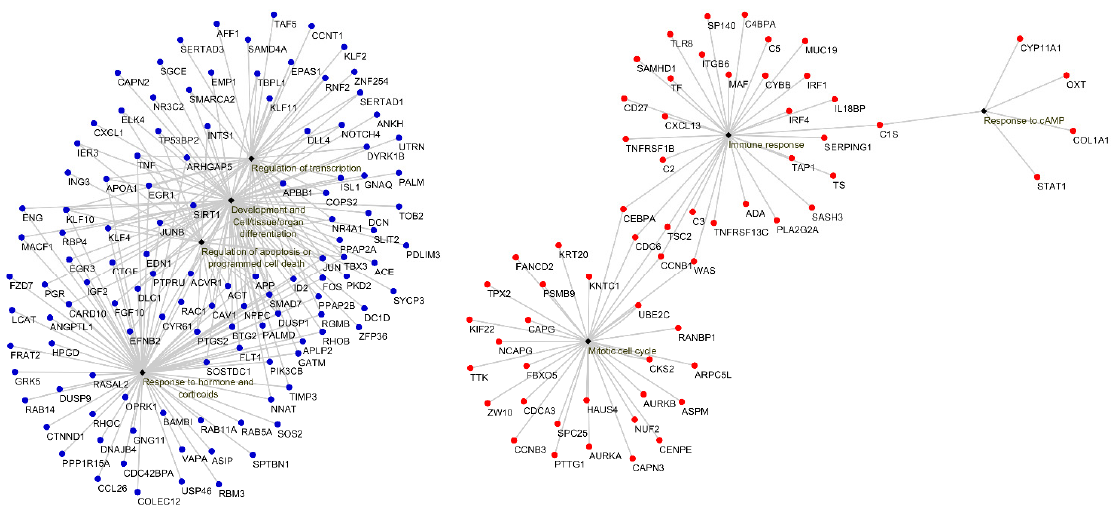
Figure 6. Enriched functional GO terms groups obtained with FatiGO (Babelomics 4.3) in the significant up-regulated (red) and down-regulated (blue) genes when comparing the Lesions group with the Asymptomatic group. p value is the highest adjusted p value of its groups GO terms: Mitotic cell cycle ( p = 3.30 × 10 − 9 ), Immune response ( p = 4.35 × 10 − 7 ), Response to cAMP ( p = 6.02 × 10 − 3 ), Development and cell/tissue/organ differentiation ( p = 2.33 × 10 − 8 ), Regulation of transcription ( p = 6.51 × 10 − 6 ), Response to hormone and corticoids ( p = 2.54 × 10 − 6 ), Regulation of apoptosis or programmed cell death ( p = 1.34 × 10 − 3 ).